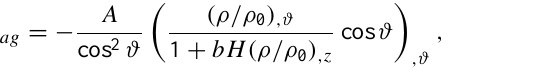
Fig. 1. The eastward baroclinic volume transport in the Southern Ocean between the southern boundary of the ACC and 30 ◦ S in the depth interval from 100 to 3000 m for pure geostrophic trans- port Q g with A = 0 (curve 1) and for the corrected transport Q with b = 10 3 , A = 6 · 10 − 4 m · s − 1 (curve 2), b = 10 3 , A = 10 − 3 m · s − 1 (curve